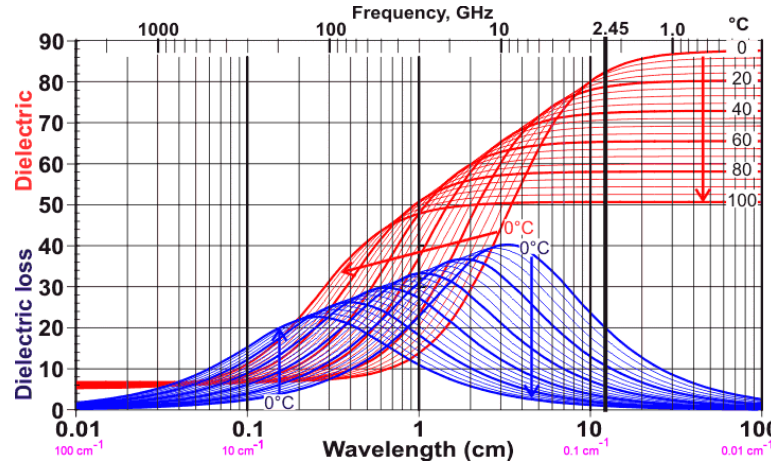
Figure 3. Complex permittivity of water as a function of frequency (Reproduced with permission [17]).